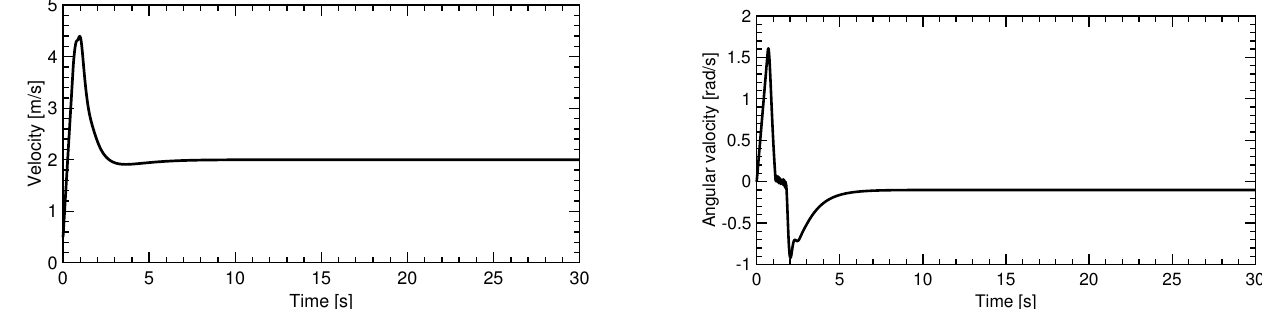
Figure 10. Trajectory following test: forward ( left ) and rotational ( right )